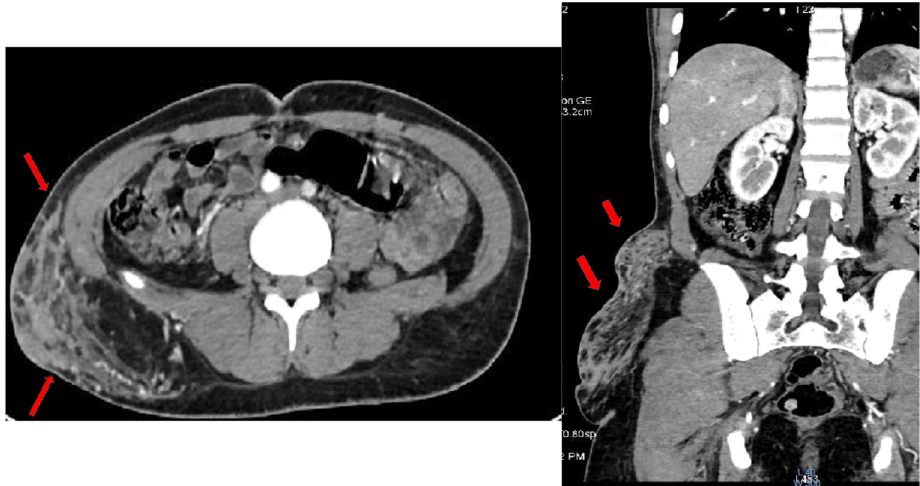
Fig. 3 A 31-year-old female with a history of NF1 presenting a subcutaneous mass that feels like a B bag of worms ^ . CT scan showed an expansive heteroge- neous image (arrows) located in the right lumbosacral external re- gion (plexiform